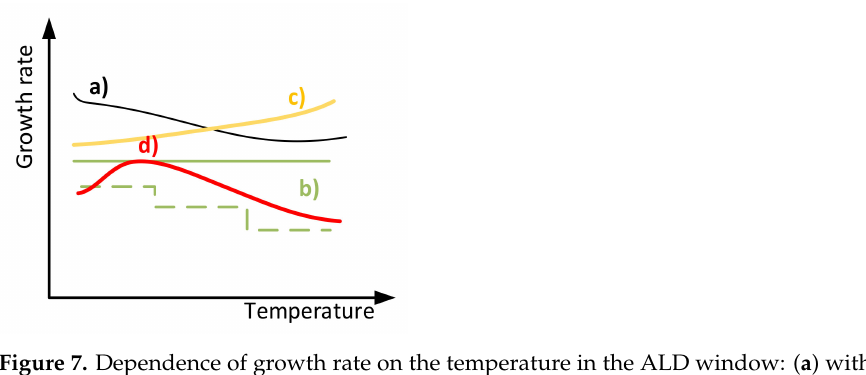
Figure 7. Dependence of growth rate on the temperature in the ALD window: ( a ) with increasing temperature, the growth rate decreases; ( b ) the growth rate is constant; ( c ) with increasing temper- ature, the growth rate increases; ( d ) the growth rate decreases with increasing temperature after reaching a maximum value [40].